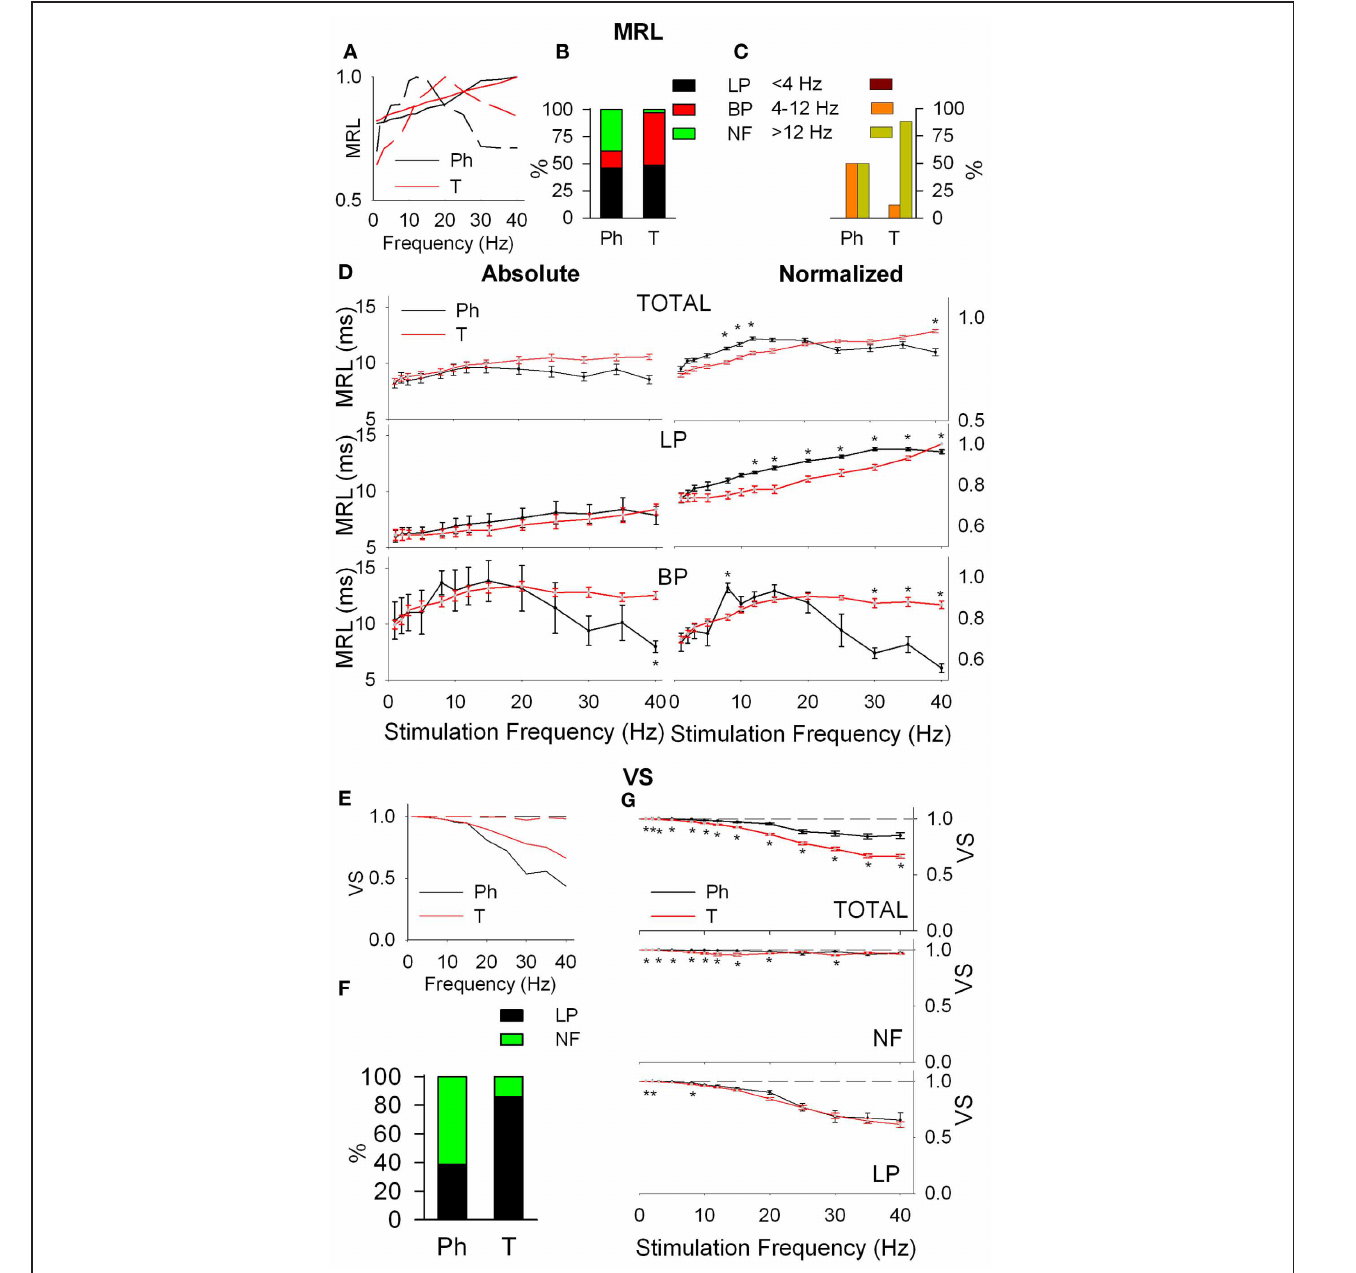
FIGURE 3 | Response latency (MRL, A–D) and temporal consistency (VS, E–G) of tonic (T) and phasic (Ph) PrV neurons. (A) Typical response latency functions of low-pass (LP, continuous lines) and band-pass (BP, dashed lines) cells. (B) Percentages of LP and BP populations among Ph and T neurons. (C) Distribution of BP peak frequencies for Ph and T neurons in the three frequency ranges: below ( < 4Hz), into (4–12Hz), and above ( > 12Hz) whisking. (D) Mean absolute (left) and normalized (right) MRL values for Ph